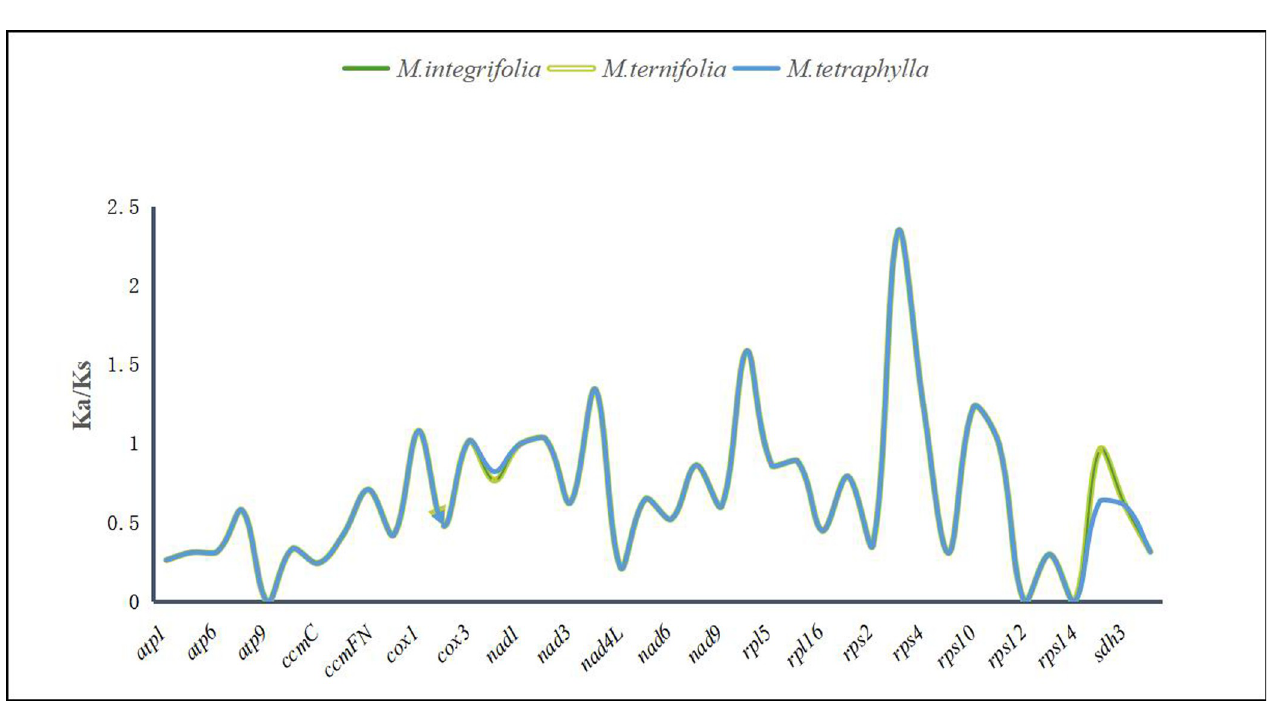
Fig 7. The Ka/Ks values of 40 protein-coding genes of three Macadamia